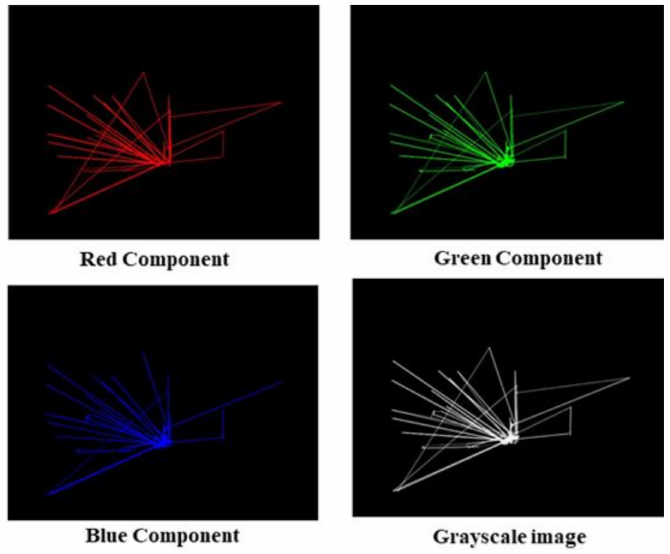
Figure 6. Three components (Red, Green, and Blue) of the ETSP and Grayscale Image. Step 2: Application of PCA to Extract